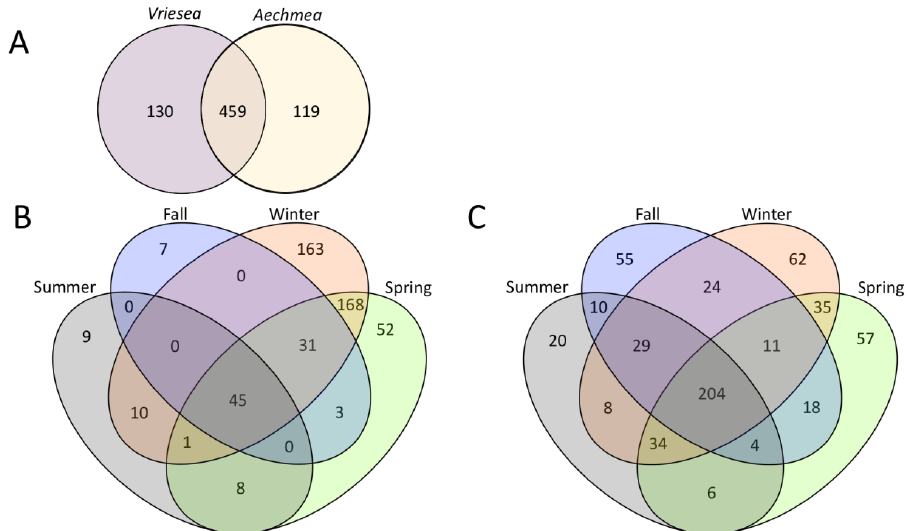
Figure 6. Venn diagrams showing the unique and shared bacterial operational taxonomic units (OTUs) ( A ) between the two bromeliad species, A. gamosepala and V. platynema ; ( B ) different seasons for V. platynema and ( C ) different seasons for A. gamosepala . Diversity 2018 , 10 , x FOR PEER REVIEW